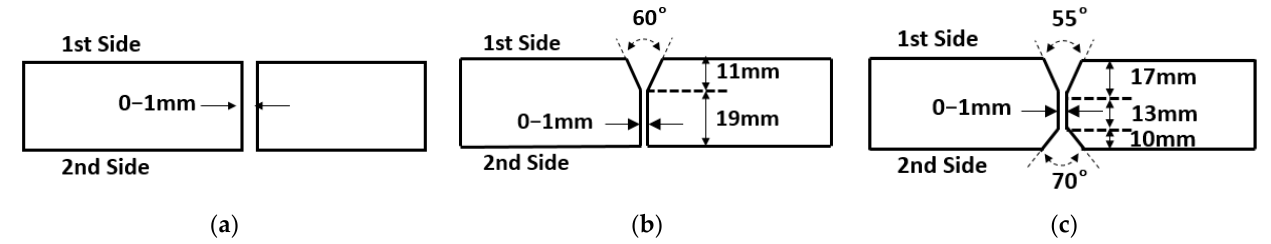
Figure 5. Joint configurations of the test coupons: ( a ) square groove for 20 and 25 mm; ( b ) Y (single V) groove for 30 mm; ( c ) double Y groove for 40 mm.